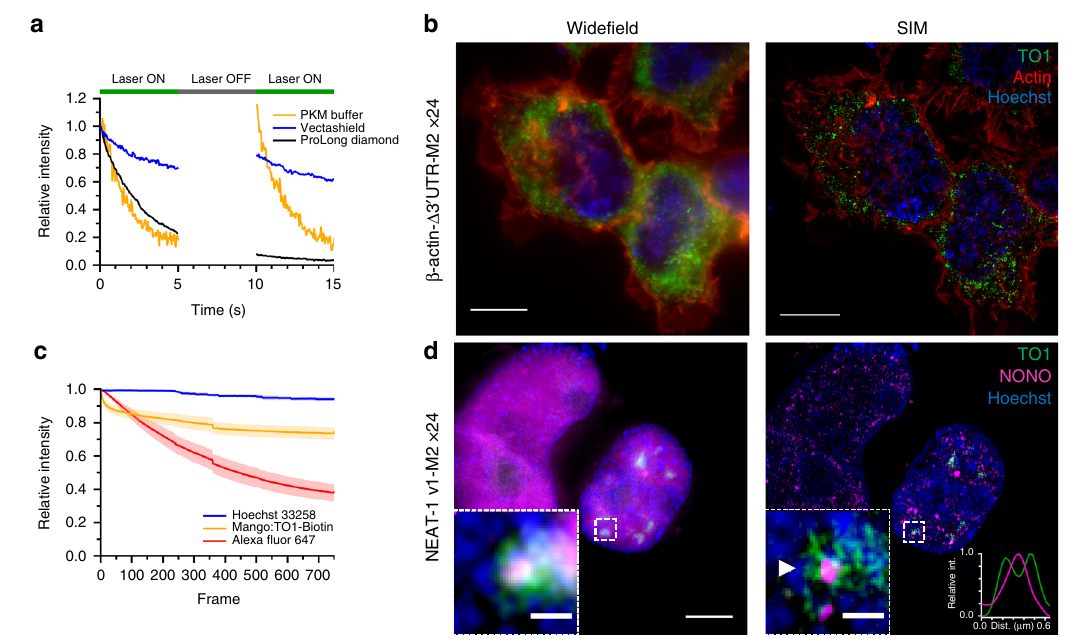
Fig. 5 Super resolved imaging of Mango tagged RNAs. a Bleaching curves of individual mCherry-M2x24 foci in fi xed HEK293T cells using different media (PKM buffer — yellow, Vectashield ® - blue and Prolong ® Diamond – black) upon 5 s intervals of constant illumination. b Wide fi eld and SIM maximum projections of the β -actin- Δ 3 ′ UTR-M2x24 construct (green) costained with Phalloidin-AF647 (red) and Hoechst 33258 (blue), scale bar = 10 µ m. HEK293T cells. c Mean intensity bleaching curves of Hoechst, Mango and Phalloidin signal during structured illumination acquisition of β -actin- Δ 3 ’ UTR- M2x24 expressing HEK293T cells. The standard deviation is plotted as the shaded area around each curve obtained from eight different fi elds of view. d Wide fi eld and SIM maximum projections of NEAT-1 v1-M2x24 construct (green) costained NONO (magenta) and Hoechst 33258 (blue) in HEK293T cells. Zoom of highlighted foci shown as inset. Large scale bars = 5 µ m, inset scale bars = 0.5 µ m. Inset intensity pro fi le (lower right) of annotated NONO foci (magenta) from SIM maximum projection showing the peripheral NEAT-1 signal